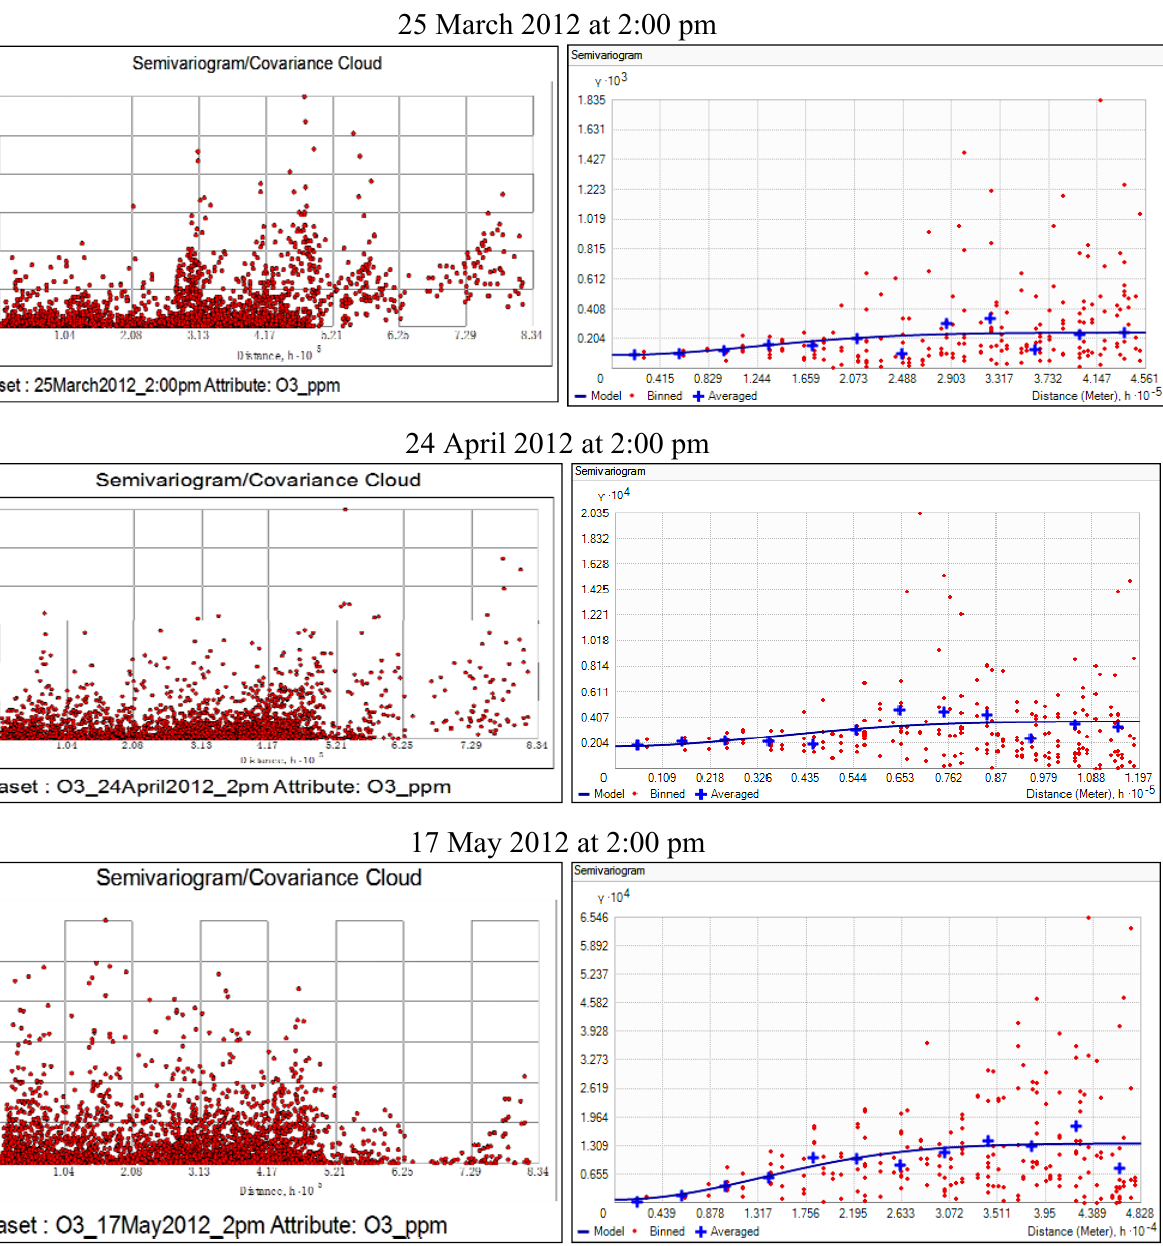
data for the studied 3